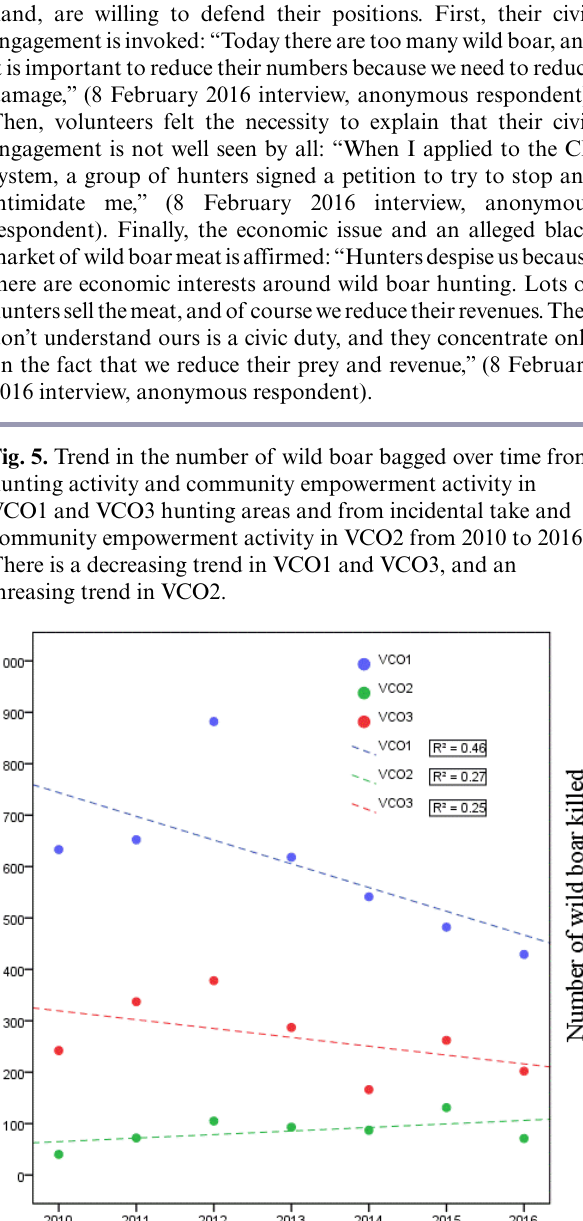
VCO3 faced a similar pattern: a change in the trend of the local wild boar population, which bottomed out at 42 individuals killed by hunting in 2016. Here, once again, hunters’ frustration